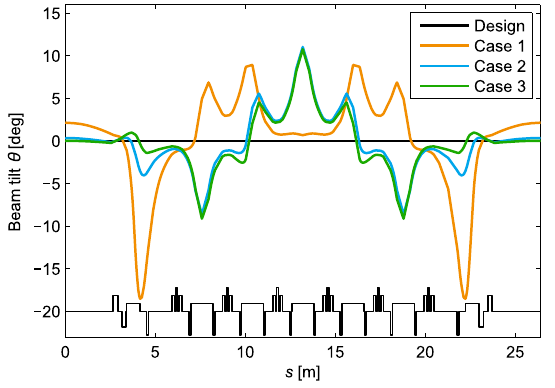
FIG. 8. Beam tilt angle Θ in the ideal lattice.